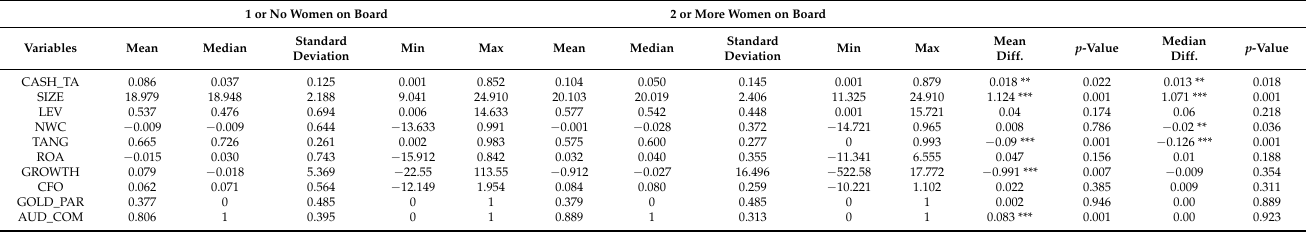
Table 2. Descriptive statistics of firms with and without a critical mass of women directors on the board.